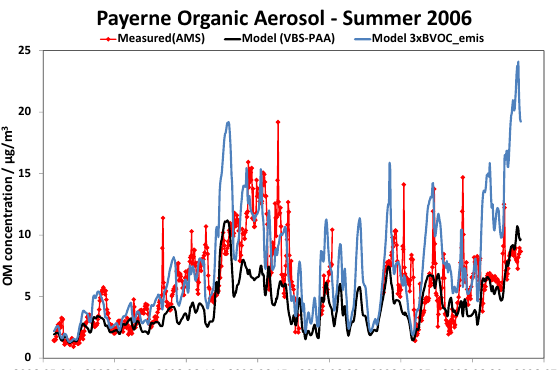
Fig. 12: Total organic mass in fine particles at Payerne, Switzerland (AMS measurements (red Fig. 12. Total organic mass in fine particles at Payerne, Switzerland curve),PM 1 andmodelcalculatedOMinPM 2 . 5 withthePAAmodelversion(blackcurve: standard (AMS measurements (red curve), OM in PM 1 and model calculated BVOCemissions,bluecurve: sensitivitytestwithBVOCemissionstripled)). Unit: µ g m − 3 . OM in PM 2 . 5 with the PAA model version (black curve: standard BVOC emissions, blue curve: sensitivity test with BVOC emissions tripled)). Unit: µg m − 3 Table 6: Organic aerosol in fine particles at Payerne (Switzerland) for the period 31 May to 3 July 2006. Comparison of EMEP PCM model results to aerosol mass spectrometry measurements and a high-resolution model study (Lanz et al., 2010; Aksoyoglu et al., 2011). Statistics for 665 hourly measurementsfortheOrganicMassandmonthlyaveragePrimaryOrganicAerosolandOther(oxi- dised)OrganicAerosolfractions.